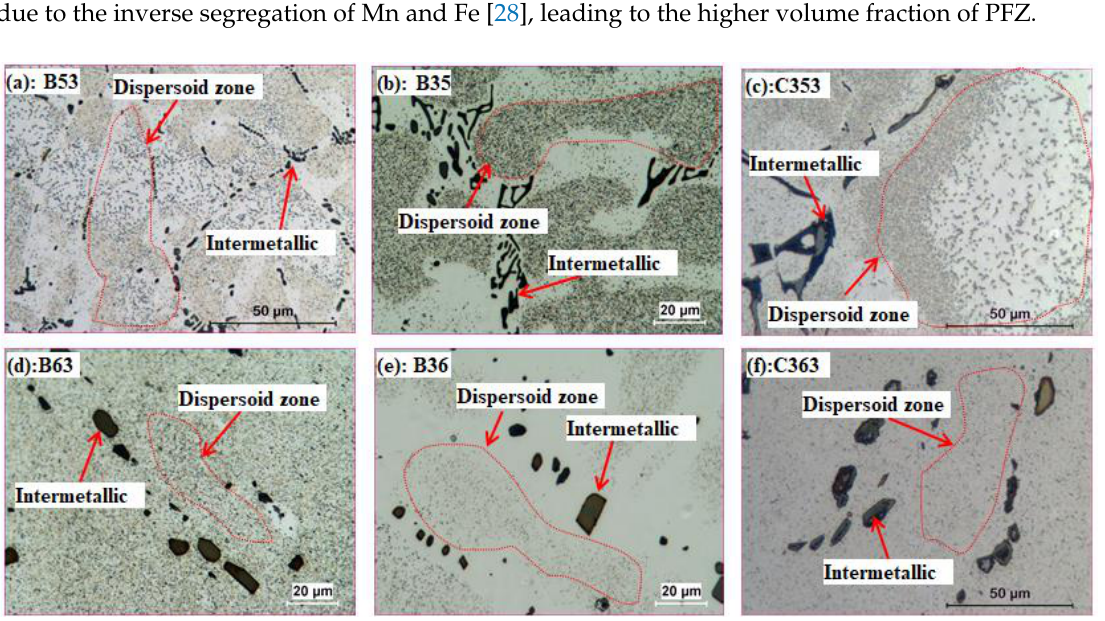
Figure 3. Distribution of dispersoids after two-step and three-step heat treatment: (a ) B53, ( b ) B35, ( c ) C353, ( d ) B63, ( e ) B36 and ( f ) C363.